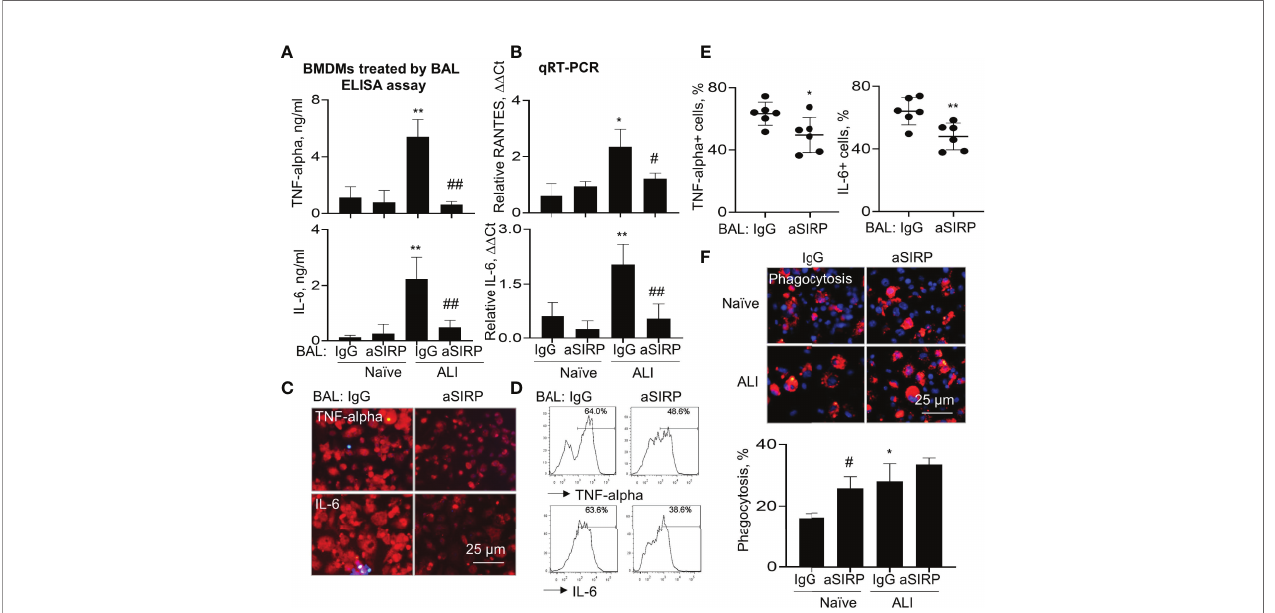
FIGURE 7 | Blockade of soluble SIRP-alpha in BAL by neutralizing antibody suppressed activation, expression of pro-in fl ammatory cytokines and improved macrophage phagocytosis. WT BMDMs were treated with 30% ALI BAL that was pre-neutralized with 2 m g/ml aSIRP or IgG isotype. (A) The expression levels of TNF-alpha and IL-6 in the supernatants of 24 hours-treated cells were measured by ELISA assay. (B) RANTES and IL-6 mRNA transcripts in the lysates of treated cells were measured by qRT-PCR. Data was presented as mean DD Ct ± standard deviation. *p < 0.05, **p < 0.01 vs. naive BAL group, # p < 0.05, ## p < 0.01 vs. IgG group, n=3. One-way ANOVA followed by Tukey ’ s multiple comparisons test. (C, D) The expression of TNF-alpha and IL-6 in ALI BAL-treated cells was analyzed by Immunostaining (representative photograph, 200 × magni fi cation) and fl ow cytometry (representative histogram). (E) Quantitative analysis of TNF-alpha and IL-6 positive cells after fl ow cytometry. *p < 0.05, **p < 0.01 vs. IgG group, 2-tailed student ’ s t test. (F) Macrophage phagocytosis of PKH26-labeled (red) apoptotic NPs after treatment with naïve and ALI BAL (representative photograph, 200 × magni fi cation, upper panel). Blue: DAPI-stained nuclei. Quantitative analysis of macrophage phagocytosis (lower panel). Data was presented as mean percentage of PKH26+ cells ± standard deviation, * p < 0.05 vs. naïve BAL; # p < 0.05 vs. IgG, n=3. One-way ANOVA followed by Tukey ’ s multiple comparisons